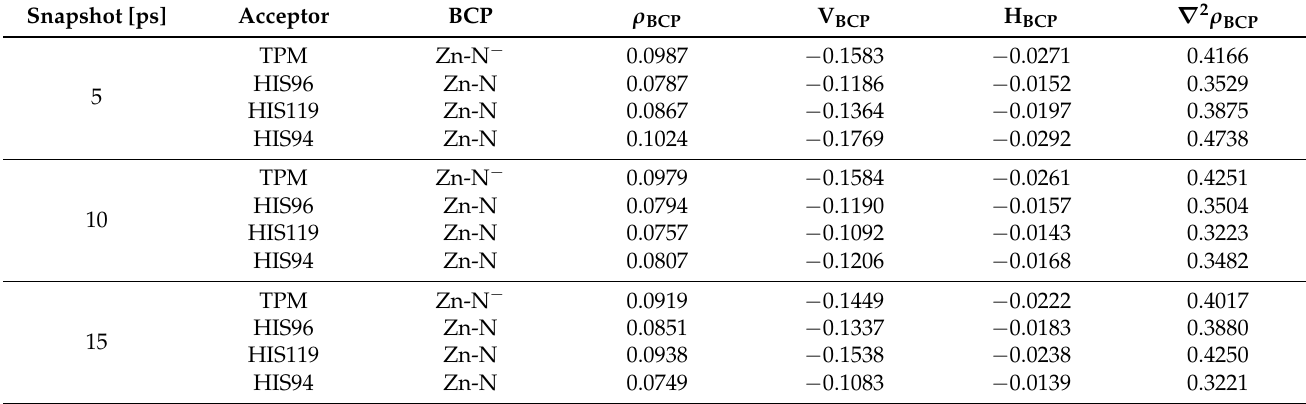
Table 3. QTAIM-derived properties at BCPs of Zn-N interactions (dative covalent bonds) taken from snapshots at approximately 5, 10, and 15 ps of the small model in the course of the QM/MM MD. Units of gathered quantities are as follows: electron density, ρ BCP , is provided in e · a − 3 units and the Laplacian of the electron density, ∇ 2 ρ BCP , is in e · a − 5 potential energy density and H BCP denotes the energy density at the BCP.